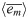
Motion error with respect to Ds.
〈em¯〉 with g = 0.02, Db = 0.1, and Ds = 0.05 for (A), and g = 0.5, Db = 0.1, and Ds = 0.005 for (B). The error bars indicate standard deviations. Note that we could not find any significant improvements due to the presence of force noise Dm. Numerical 〈em¯〉 is computed from 500 trials of a 500 s numerical simulation, and the error bars correspond to the standard error.